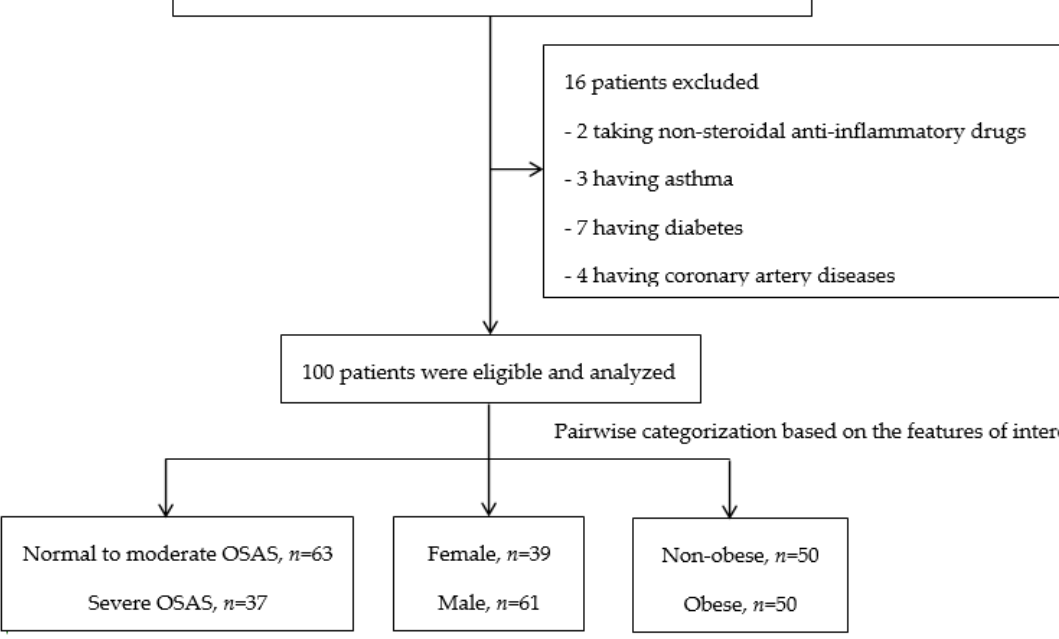
Figure 1. The patient enrollment flow chart. Abbreviations: OSAS, obstructive sleep apnea syndrome.